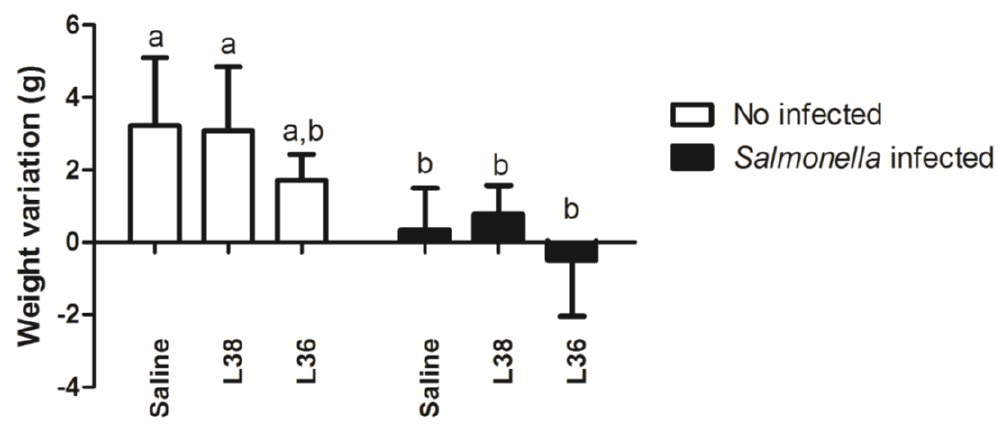
Figure 1. General health indicators of L38- and L36-pretreated mice on the 9th day post -Salmonella challenge. ( a ) Animal weight variation; ( b ) hepatic size index; ( c ) splenic size index. Results were expressed as mean of weight variation (g), hepatic size index (mg of spleen/g total weight), and splenic size index (mg of liver/g total weight) ( n = 10 per group). The vertical bars indicate the standard deviation of means. Different letters over the bars indicate statistically significant differences between the experimental groups ( p <